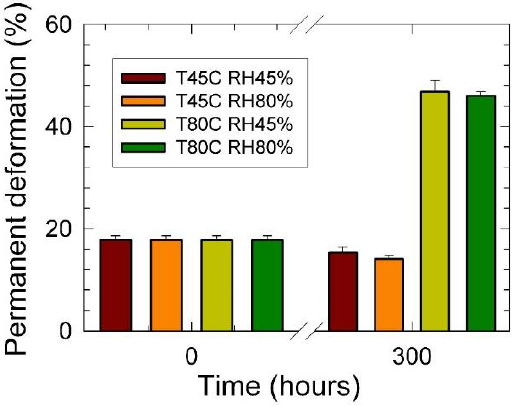
Figure 6. Permanent deformation vs. conditioning time dependencies of studied PU foams at different temperatures and relative humidity. Inset: T — temperature (°C), RH — relative humidity (%).